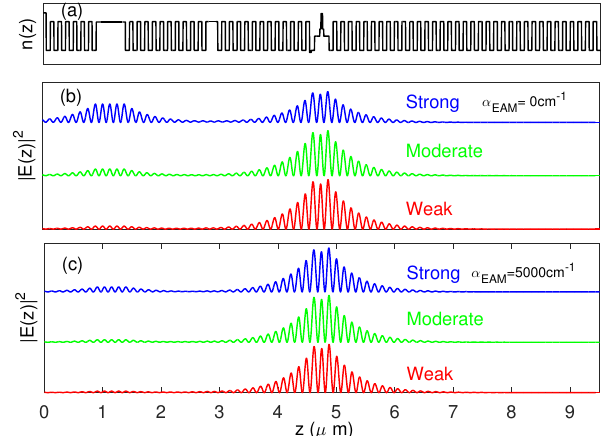
Figure 2. (color online) Optical power distributions along the EAM-VCSEL for the composed cavity mode situated primary in the VCSEL cavity and for strong— d EAM = 0.4972 µ m (blue), moderate— d EAM = 0.5 µ m (green) and weak— d EAM = 0.502 µ m (red) coupling between the EAM and the VCSEL cavities. The top black line in ( a ) indicates the refractive index profile of the structure. The middle ( b ) and the bottom ( c ) panels are for absorption in the EAM QW regions of α EAM = 0cm − 1 and α EAM = 5000cm − 1 ,